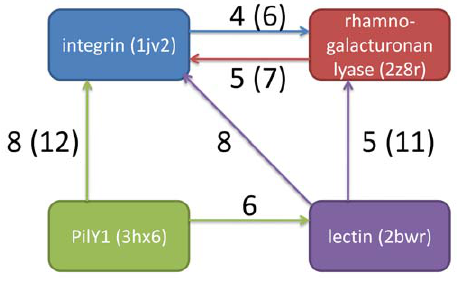
Figure 5. Schematic representation of statistically significant relationships between calcium blades revealed by JackHMMER [ 39 ] iterative database searches. Arrows indicate retrieval of a given motif by a query, with numbers indicating the number of iterations required at e-values of 0.01 or, bracketed, 0.001.